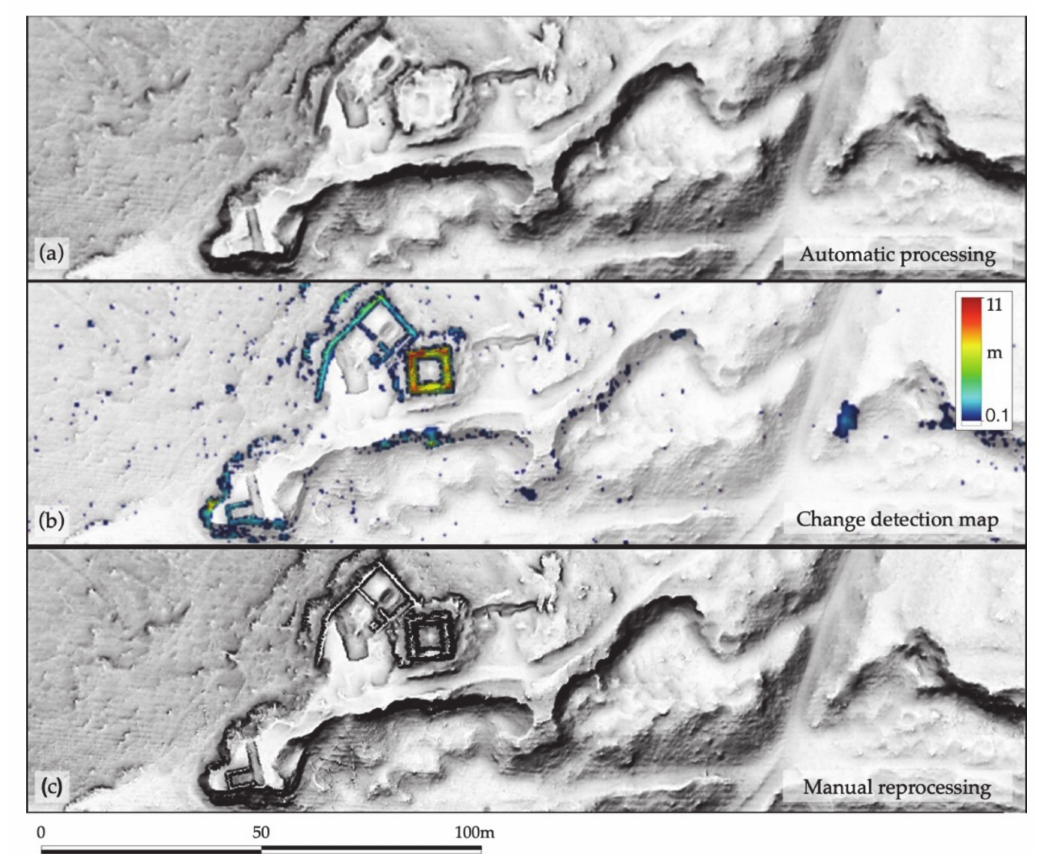
Figure 7. Test site AT, change detection map clearly demonstrates the location and intensity of manual reclassification: ( a )—automatic processing DFM; ( b )—change detection map (calculated as |(c) − (a)|); ( c )—manual reclassification DFM. Note the color scale, changes under 0.1 m are not shown. DFM processing: see Table